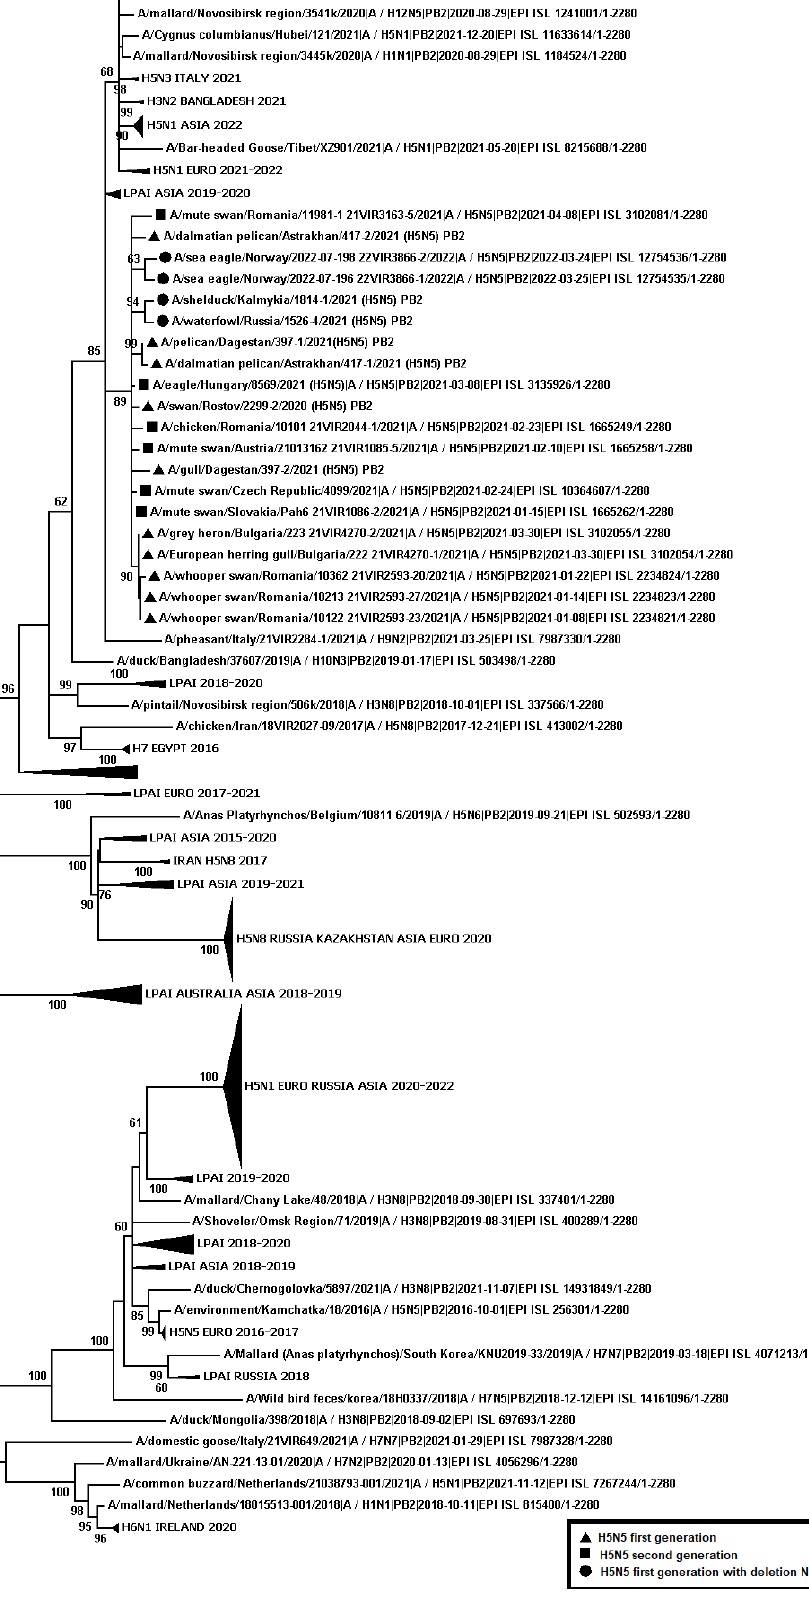
Figure 5. Phylogenetic tree constructed using the NJ method, based on the nucleotide sequence of the PB2 gene fragment (1–2280 bp ORF) of AIV subtype H5.